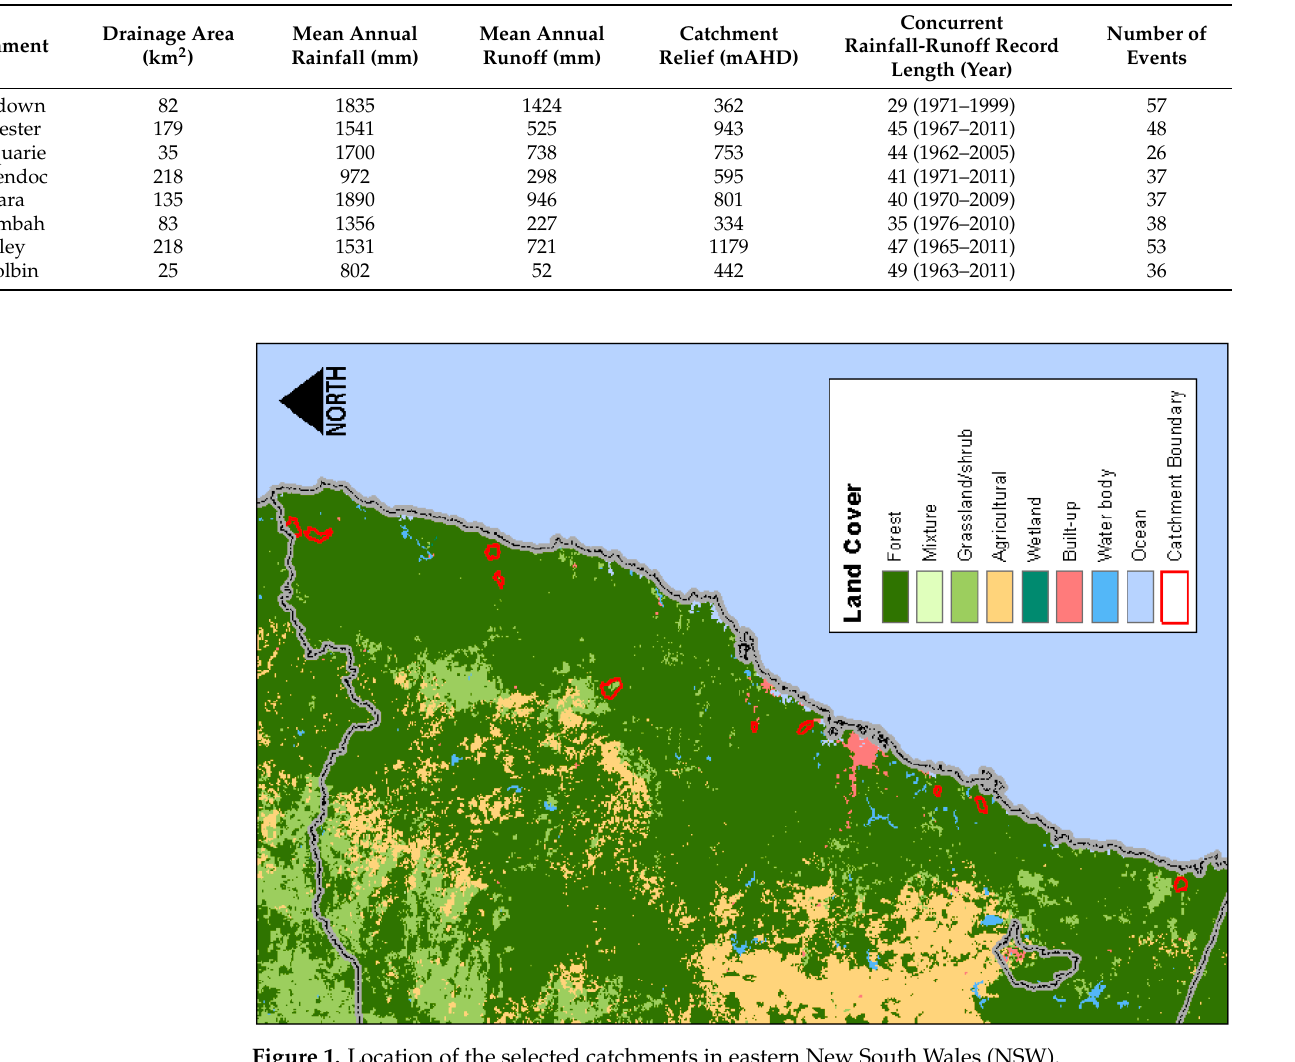
Figure 1. Location of the selected catchments in eastern New South Wales (NSW).